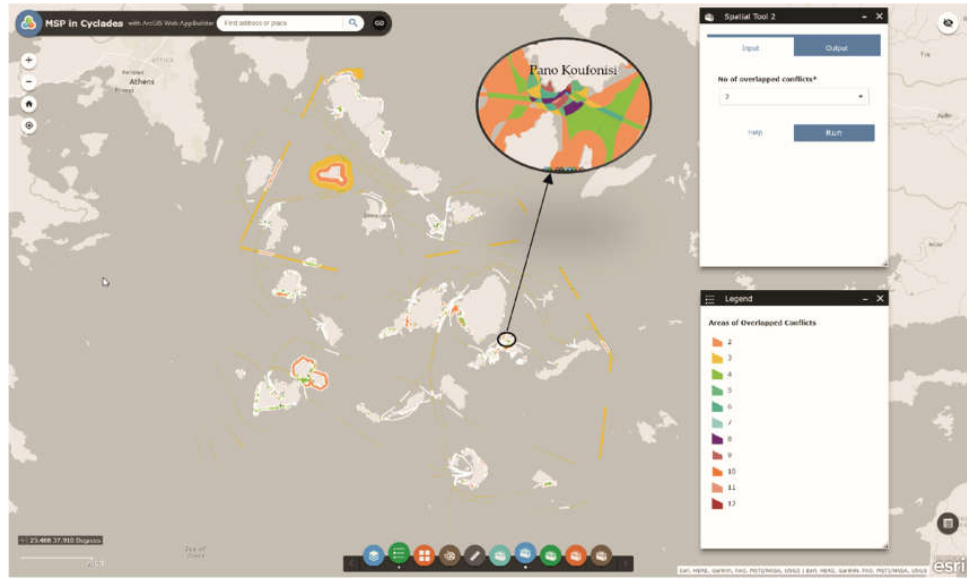
Figure 4. Areas where more than two conflicts co-exist.